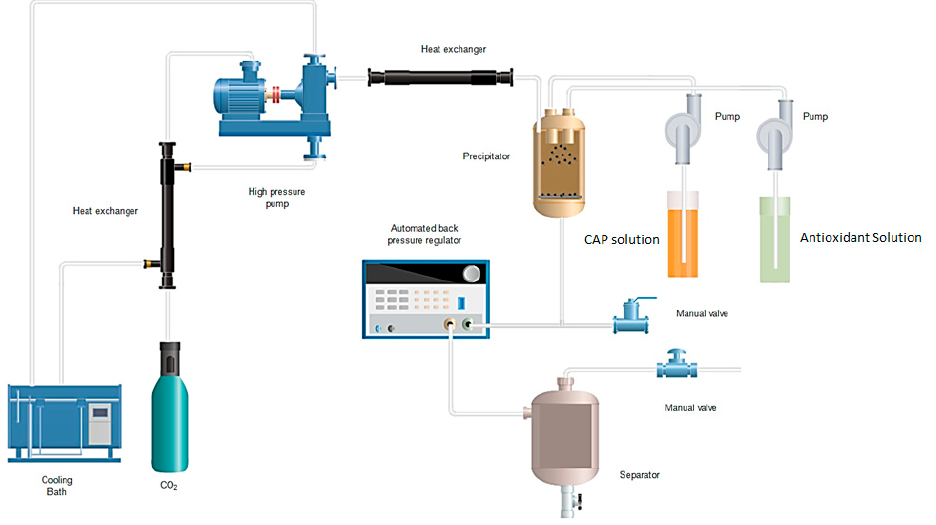
Figure 2. Schematic diagram of the supercritical antisolvent device, SAS2 .